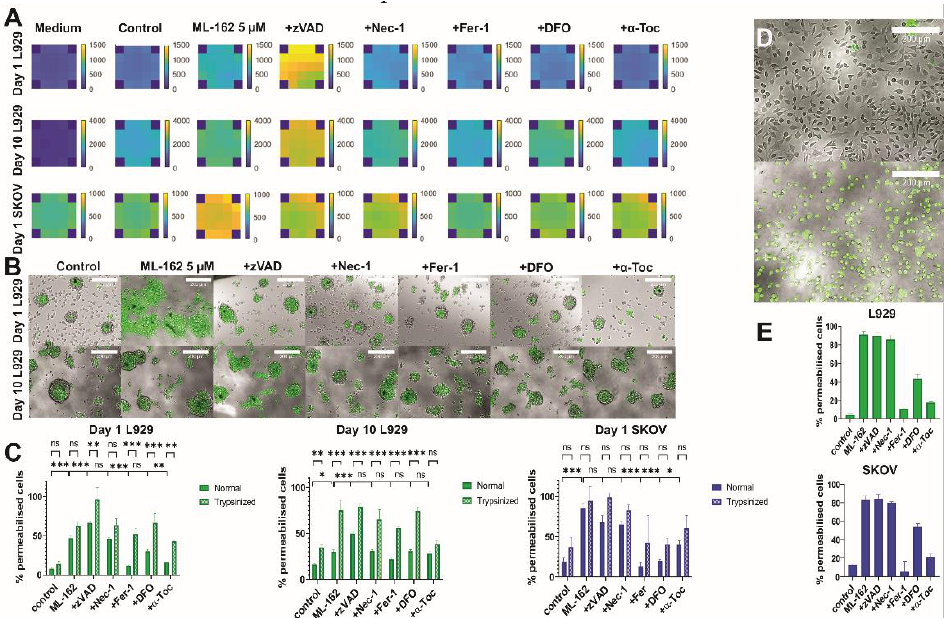
Figure 4. Validation of 3DELTA—quantification of ferroptotic cell death in spheroids. Ferroptosis was induced using 5 µ M ML-162. Spheroids were stained with Sytox Green (L929) or Sytox Blue (SKOV) and cell death was measured after 24 hours as increase in fluorescence intensity using Tecan Spark microplate reader. Afterwards, spheroids were permeabilised with Triton X-100 0.05% ( v / v ). Fluorescence intensity was measured and used as 100% cell death. ( A ) Sytox was measured in a consistent, predefined pattern (21 positions per well), and heat maps of the entire well were generated in Matlab based on fluorescence intensities. Optimal gains were used for each cell line (gain 45, D1 L929; gain 45, D10 L929; gain 55, D1 SKOV). The corners shown here are zero values as these areas were not measured in the predefined Tecan Spark scan pattern. Experiments were performed in triplicate and representative images are shown here. ( B ) Fluorescence pictures of day 1 and 10 L929 spheroids. Control spheroids show cell death in their core which might be due to hypoxia leading to a necrotic core. Representative images are shown here. Scale bar = 200 µ m ( C ) Quantification of cell death in normal and trypsinized spheroids. Data are averages from three independent experiments ( n = 3), each measured in triplicate; error bars = SEM. * p < 0.05, ** p < 0.01, *** p < 0.001, ns = not significant. The first line represents the comparison between standard and trypsinized spheroids and the second line represents the comparison between control spheroids and spheroids induced with ML-162 and between induced spheroids and spheroids where inhibitors were added. ( D ) Brightfield image of control (upper panel) and induced (lower panel) L929 cells. All cells are stained with Sytox Green. ( E ) Quantification of cell death in L929 (upper panel) and SKOV (lower panel) 2D